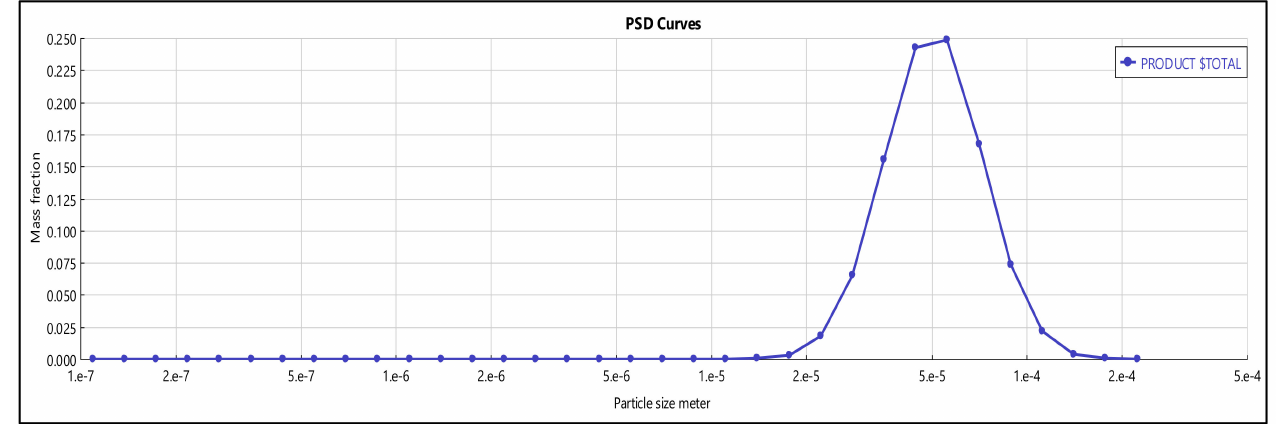
Figure 9. Particle size distribution of the spray-dried date sugar